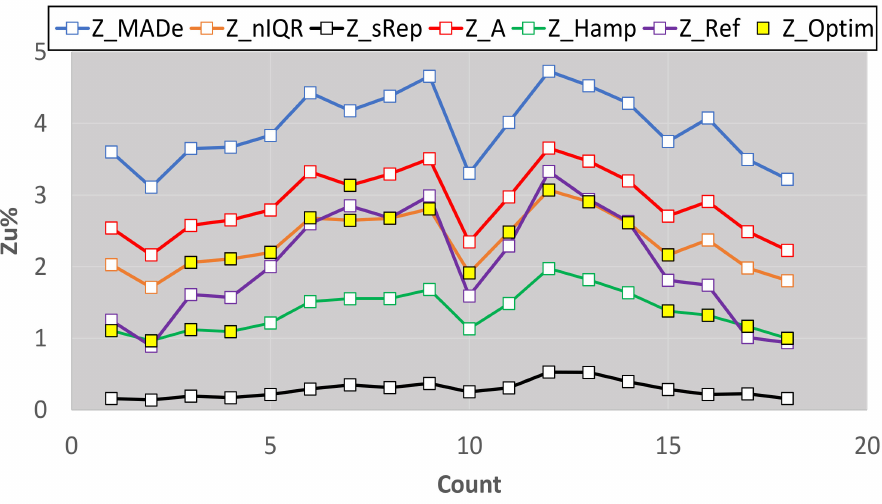
Figure 16. Estimators of Zu% for 18 rounds of the 28-day strength